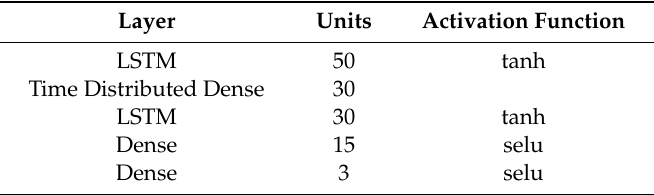
Table 5. LSTM: units and activation functions of each layer.